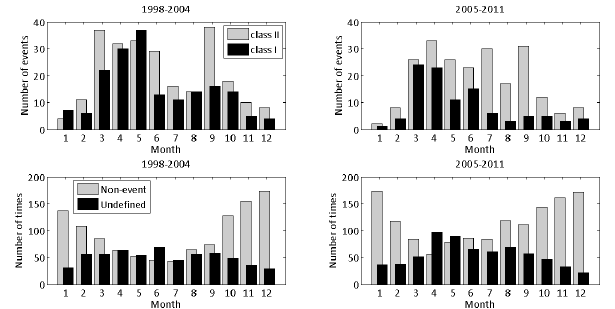
Fig. 6. The seasonal distribution of events, non-events and un- Figure 6 The seasonal distribution of events, non-events and undefined days during 1998-2 defined days during 1998–2004 (leftmost panels) and 2005–2011 2004 (leftmost panels) and 2005-2011 (rightmost panels). 3 (rightmost